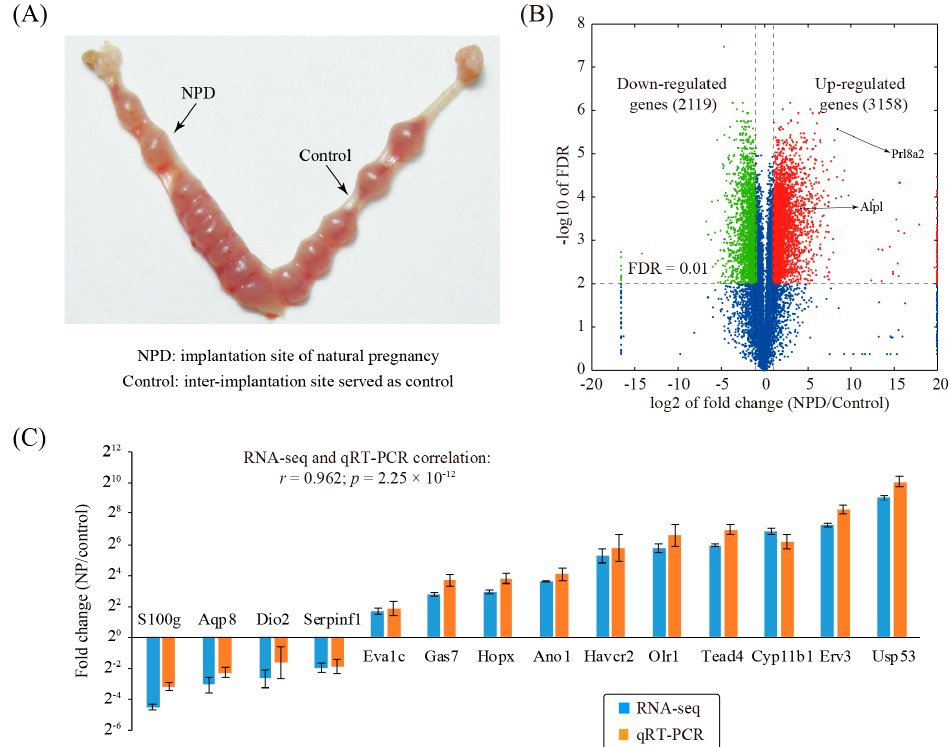
Figure 1. Identification of changed genes in natural pregnancy decidualization (NPD). ( A ) A photograph showing the mouse uterus from day 8 of natural pregnancy. ( B ) Volcano plot showing the comparison between the implantation sites of natural pregnancy decidualization (NPD) and the non-decidualized inter-implantation sites (control) in mice. The cutoff values for differentially expressed genes were: fold change ≥ 2 and FDR ≤ 0.01. Red, green, and blue colors are indicative of up-regulated genes, down-regulated genes, and non-changed genes, respectively. ( C ) Validation of a panel of selected genes by using qRT-PCR. Data obtained from qRT-PCR were displayed as mean ± SEM (standard error of mean). According to the t-test, p < 0.05 is true for all genes. n = 3.